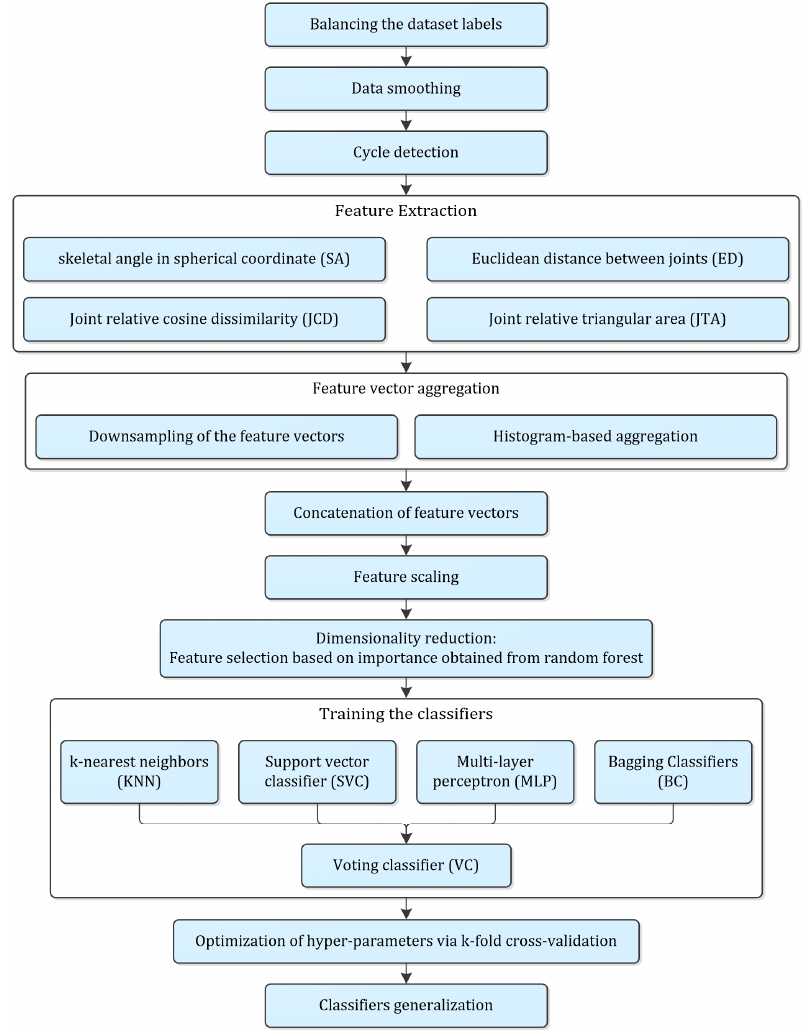
Figure 3. Flow diagram of the entire procedure proposed in the present study.